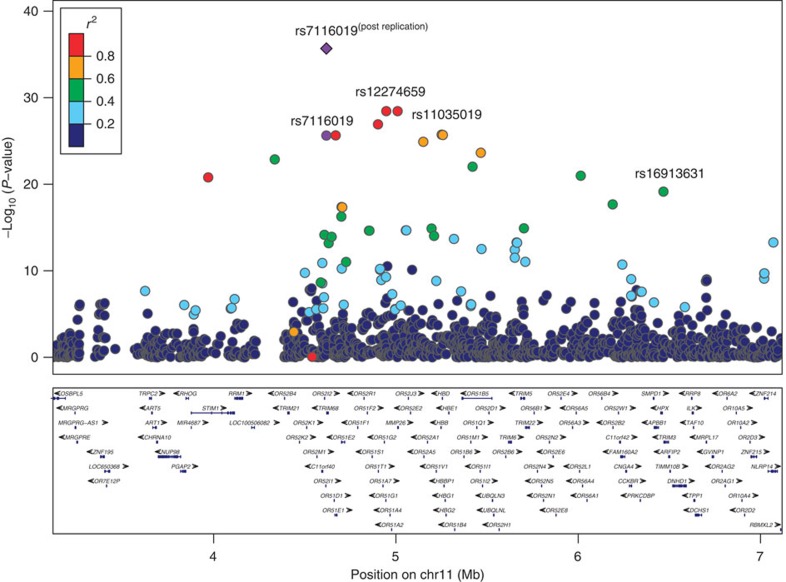
Association of variants at chr11p15.4 with MCV.The x axis shows the genomic interval, the left y axis shows the statistical significance of association as negative log10 of P values (score test in GEMMA). rs7116019 was used as the reference SNP and its P value in the discovery set and post replication is denoted by the purple circle and diamond, respectively. In addition, annotated are variants that show the highest genetic drift (rs16913631) and most significantly associated with MCV (rs12274659 and rs11035019). The linkage disequilibrium was calculated dynamically from our own data and is presented as pairwise r2 between the reference SNP and the other SNPs in the region with colours according to different bins (0–0.2, dark blue; 0.2–0.4, light blue; 0.4–0.6, green; 0.6–0.8, orange; 0.8–1.0, red). The plot was produced using LocusZoom68.